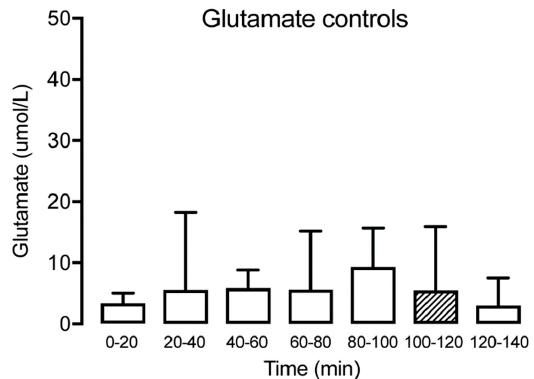
Figure 4. Interstitial glutamate at different time points for the healthy control group ( n = 15) showing no significant alteration over time. The hatched box indicates time point T100–120, often used as a baseline.